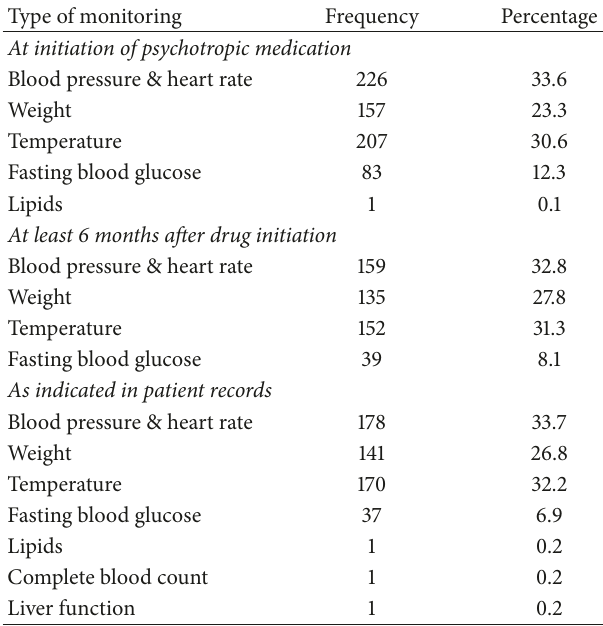
Table 7: Monitoring of side effects.